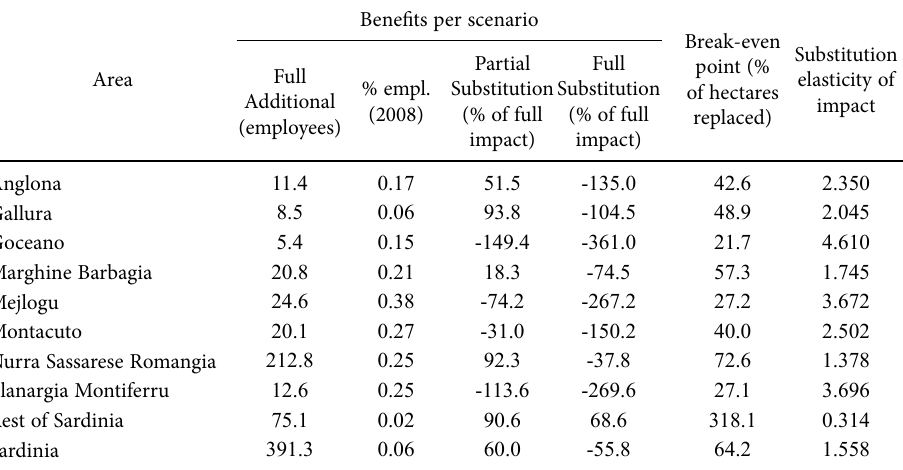
Table 5. Impacts produced by the cardoon supply chain in terms of employment, Sardinia, Italy.